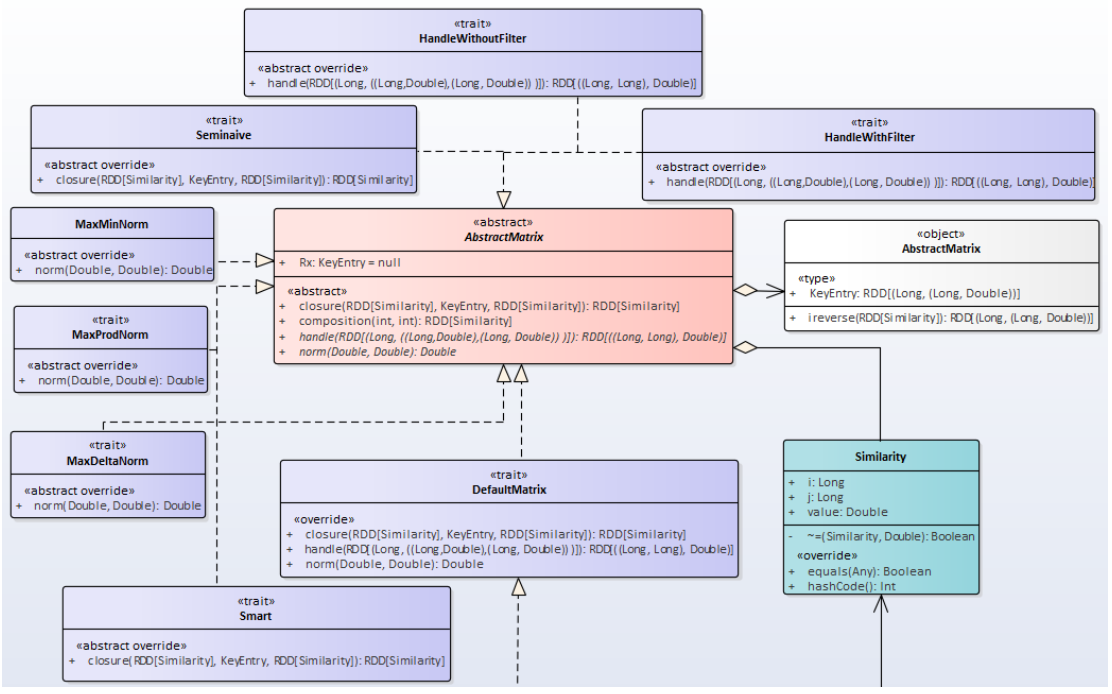
Figure 1. The project’s main abstract